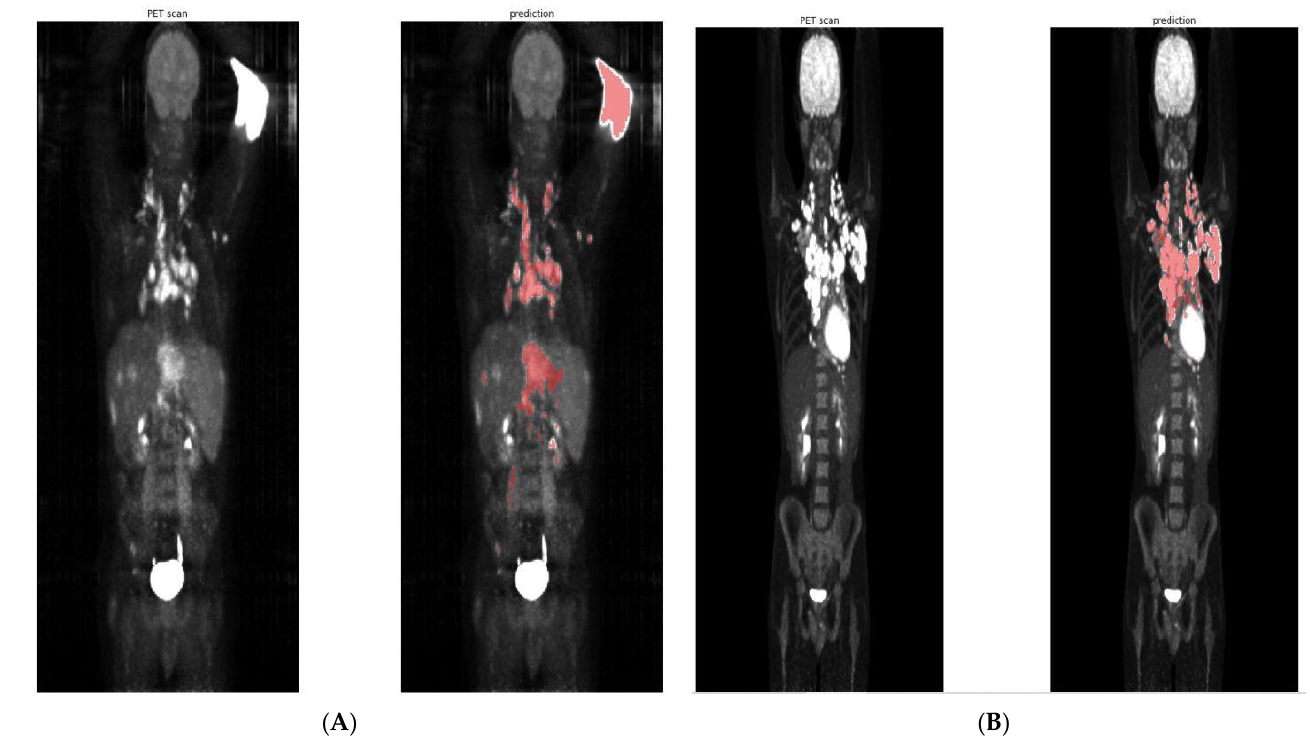
Figure 4. Predictions with false positives at the left arm FDG injection site, dice =0.32 ( A ) vs. accurate predictions, dice = 0.84 ( B ) of two different patients from the AHL cohort (HL).